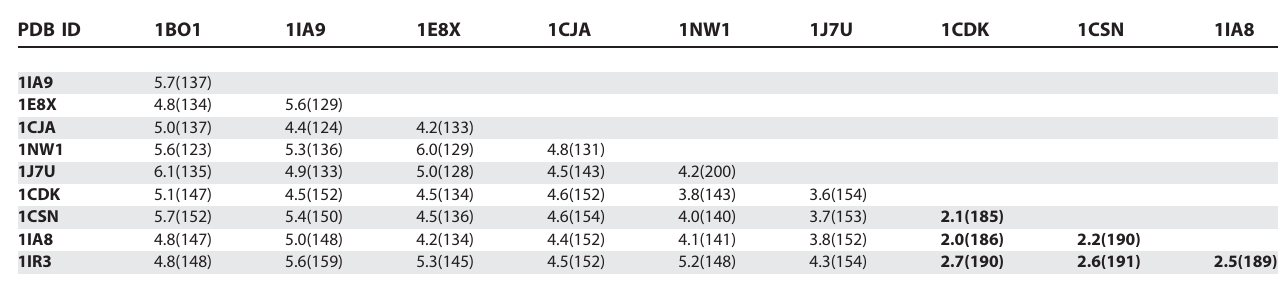
Table 4. RMSD and Number of Aligned Residues from Representative Kinase Structure Alignments, When Superposed Based on the Alignment Presented in Figure